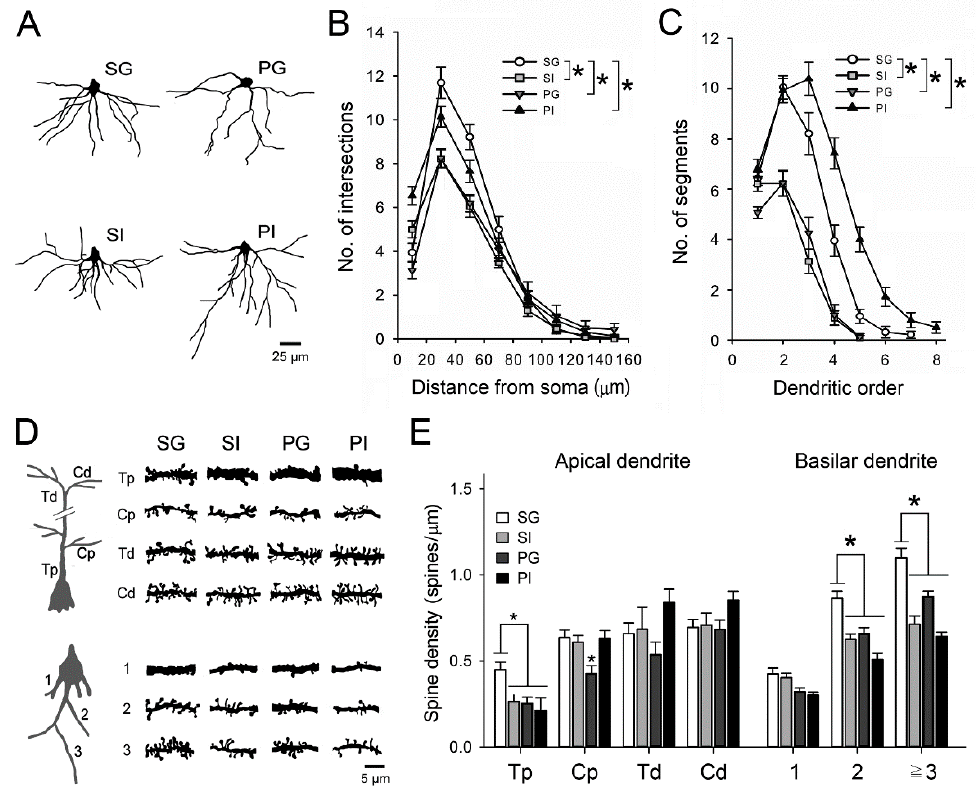
Figure 7. Dendritic features of layer II / III pyramidal mPFC neurons. ( A ) Somata and basilar dendrites of Golgi − Cox impregnated pyramidal neurons were reconstructed. Spines are omitted in this illustration. ( B ) The complexity of basilar dendrites was estimated using the concentric sphere method of Sholl and ( C ) the number of dendritic segments. ( D ) Dendritic segments obtained from apical and basilar dendrites are illustrated. ( E ) In the apical dendrites, fragments were collected from the trunk (T) and collaterals (C) from the proximal ( < 100 µ m from the soma) and distal (near the surface) regions. In the basilar dendrites, fragments were classified by the dendritic order. The densities of dendrites in di ff erent dendritic segments were measured. Results are mean ± SEM. * p < 0.05. Table 1. Morphometric features of basilar dendrites in layer II/III pyramidal neurons in the mPFC. SG: n = 19 neurons, SI: n = 23 neurons, PG: n = 16 neurons, PI: n = 32 neurons; neurons were obtained from 6 mice in all groups. Data are presented as the mean ± SEM. * p < 0.05 compared to the SG group. SG